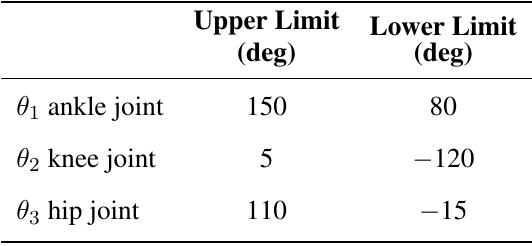
Table 2. Range of motion and constraints imposed in the